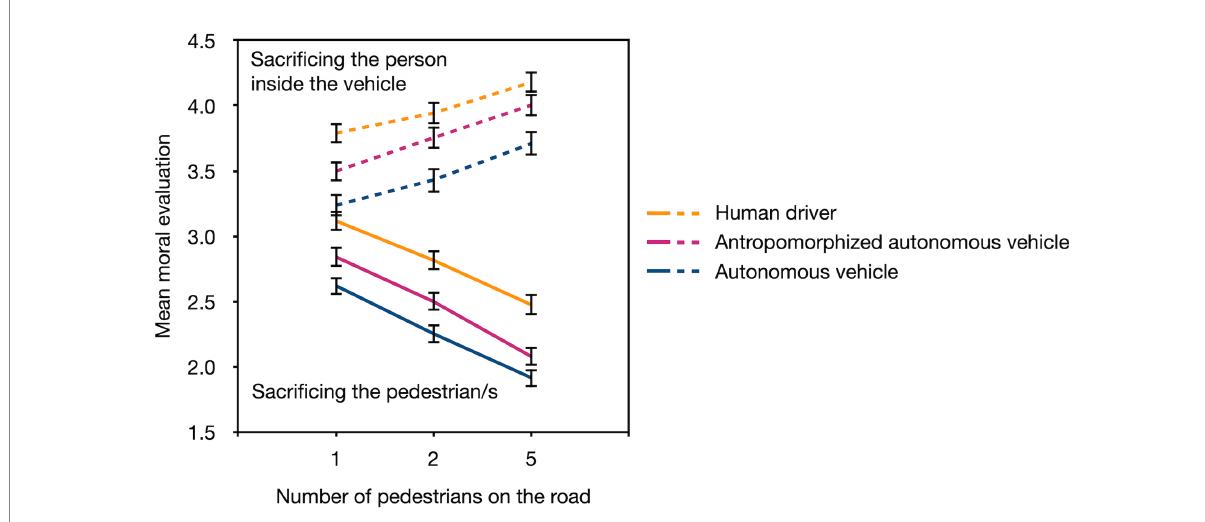
FIGURE 3 The mean moral evaluation of the actions (sacrificing the person inside the vehicle [dashed lines], sacrificing the pedestrian/s [solid lines]) as a function of the number of pedestrians on the road (1, 2, and 5) and the agent (human driver, anthropomorphized autonomous vehicle, autonomous vehicle). The moral-evaluation scale ranged from “very reprehensible” (1) to “very justifiable” (6). The error bars represent standard errors of the